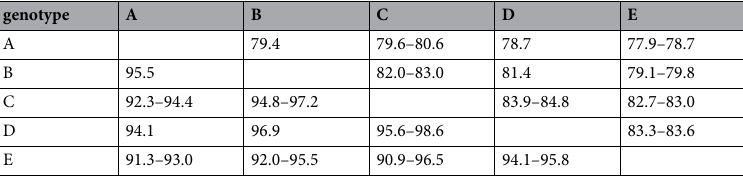
Table 2. The complete VP1 nucleotide and amino acid sequences comparisons between the E-18 gene clusters. Note: the data in the upper right corner was for nucleotide homology analysis and the data in the lower left corner was for amino acid homology analysis.